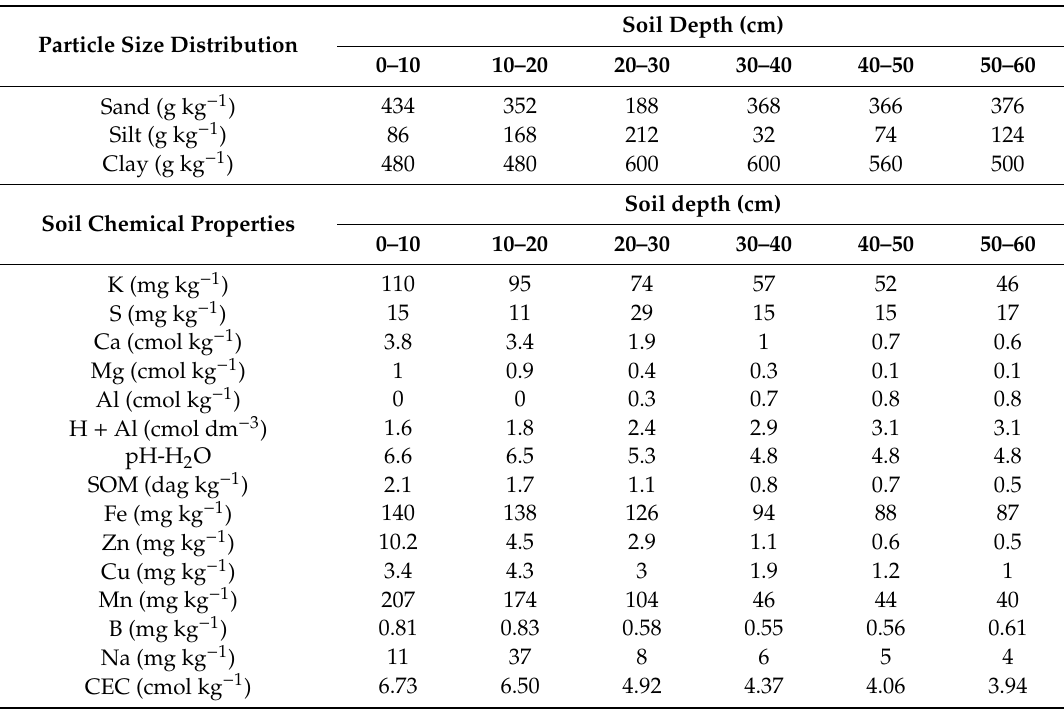
Table 1. Particle size distribution and soil chemical properties of six soil depths in an irrigated co ff ee farm located in Nova Ven é cia, Brazil.